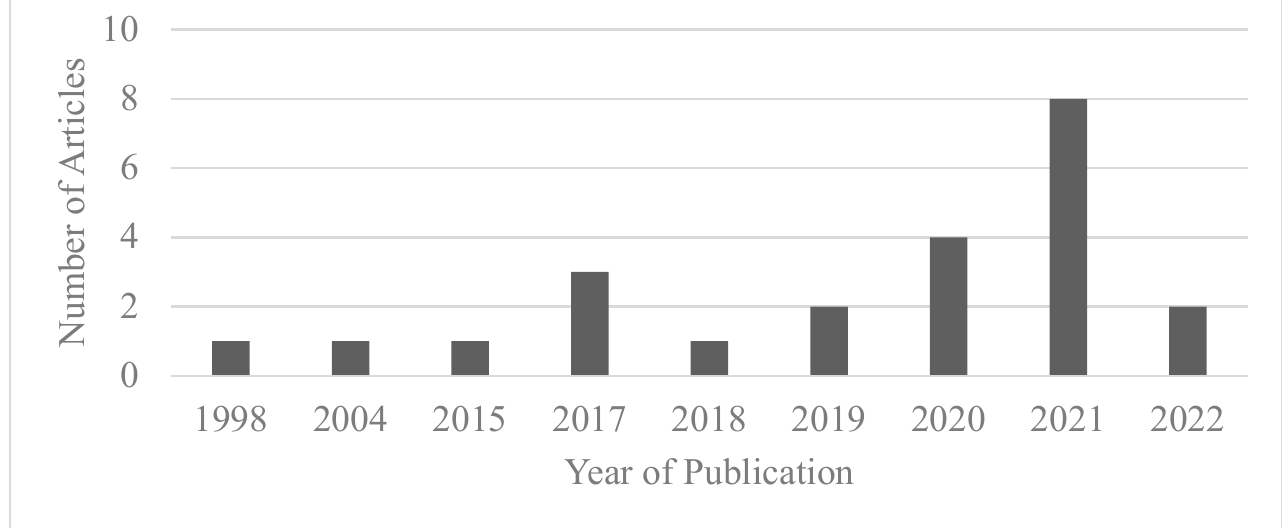
Figure 2. Annual distribution of articles throughout 1998–2021. Table 3. Mapping the challenges affecting women in the Australian construction industry in the literature.